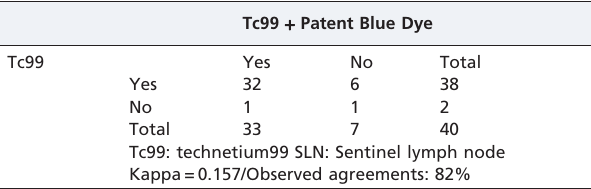
Table 6 - Kappa coefficient of concordance when comparing technetium isolated with a combination of Tc99 and Patent blue dye in the identification of the